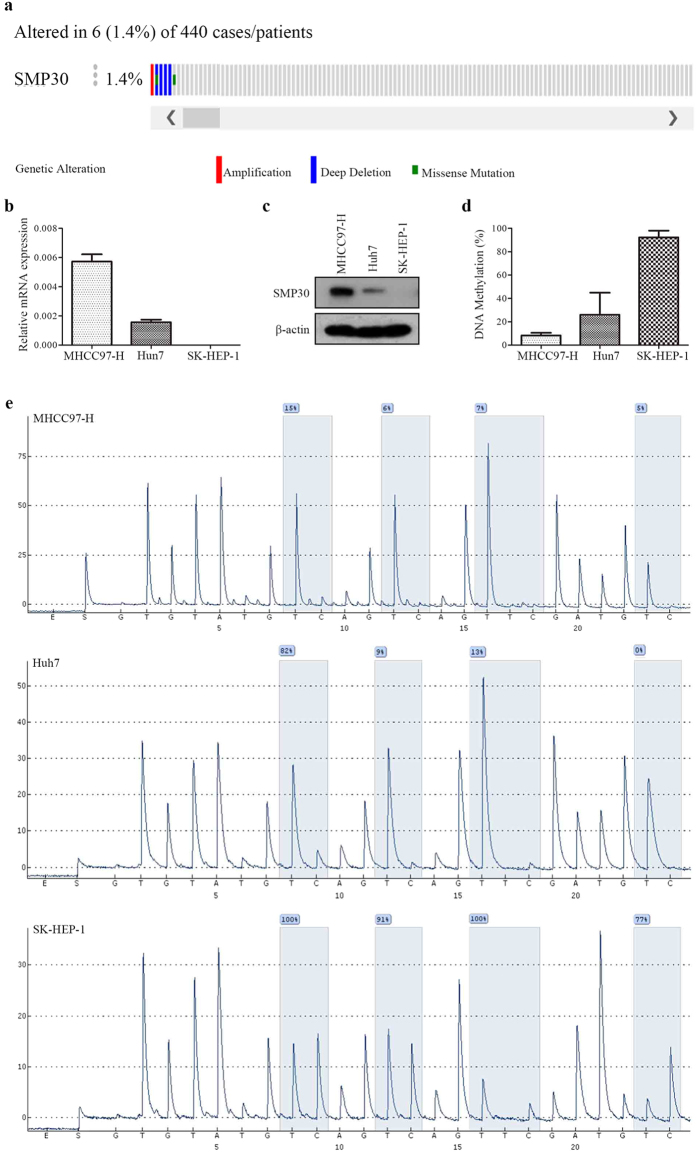
Showing genetic alterations and relationships between methylation status of SMP30 and SMP30 expression.(a) Genetic alteration of SMP30 provided by the cBioPortal. (b) Relative mRNA expression of SMP30 in HCC cell lines MHCC97-H, Huh7 and SK-HEP-1 detected by qPCR. (c) SMP30 protein expression in HCC cell lines MHCC97-H, Huh7 and SK-HEP-1 detected by western blotting. (d) The average DNA methylation levels of 4 CpG sites of SMP30 gene detected in HCC cell lines MHCC97-H, Huh7 and SK-HEP-1. (e) The methylation percentages of 4 CpG sites of SMP30 detected in HCC cell lines MHCC97-H, Huh7 and SK-HEP-1 by pyrosequencing.